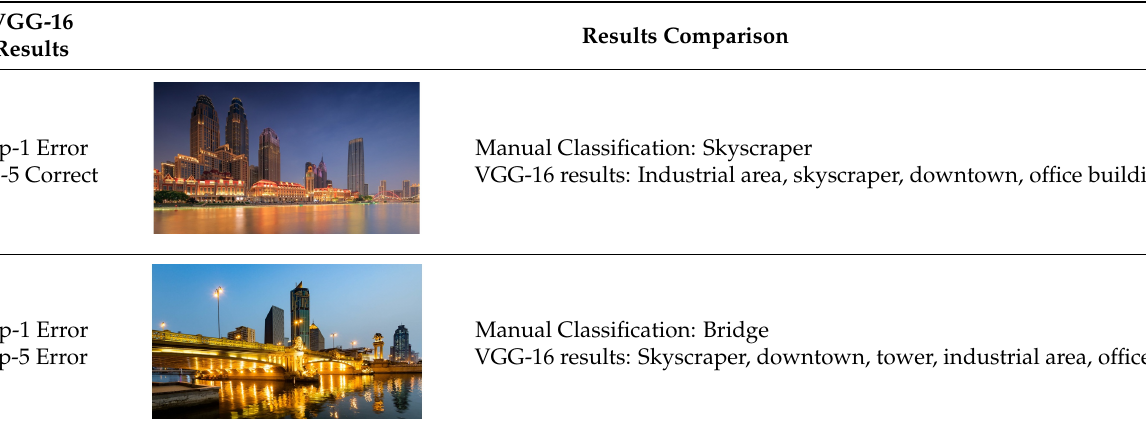
Table 2. Examples of Top-1 and Top-5 Error classification.